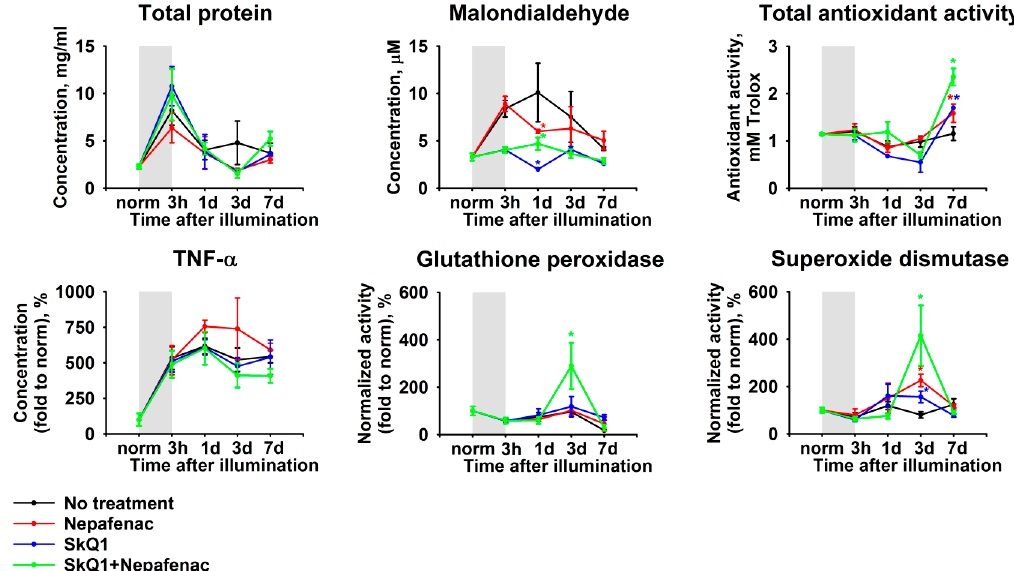
Figure 7. Alterations in biochemical properties of rabbit AH under conditions of LIRD without treatment (black), in the course of treatment with Nepafenac (red), after premedication with SkQ1 (blue), and in the course of the therapy using the combination of the both drugs (green). The animals were illuminated with intense visible light (30,000 lx) for 3 h (the course of the illumination is shown as a gray box). The AH samples were collected before (norm) and immediately after (3 h) the illumination as well as on 1, 3, and 7 day post-exposure. The samples were analyzed for TNF- α and malondialdehyde content as well as total antioxidant activity (in Trolox equivalent) and activity of glutathione peroxidase and superoxide dismutase using the respective assays. * p > 0.05 as compared to the parameters of AH of the untreated illuminated animals.